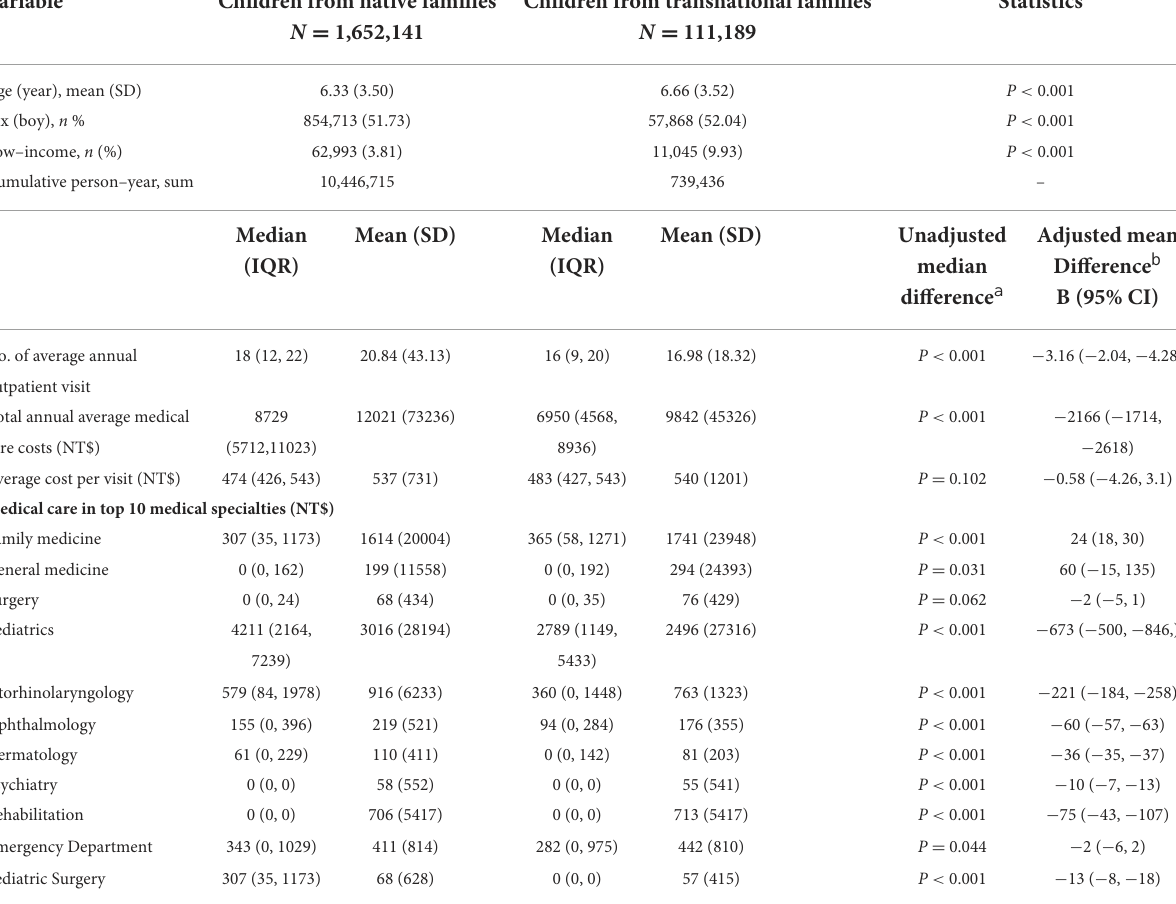
TABLE 2 Demographics, medical use and costs between children from transnational and native families. Variable Children from native